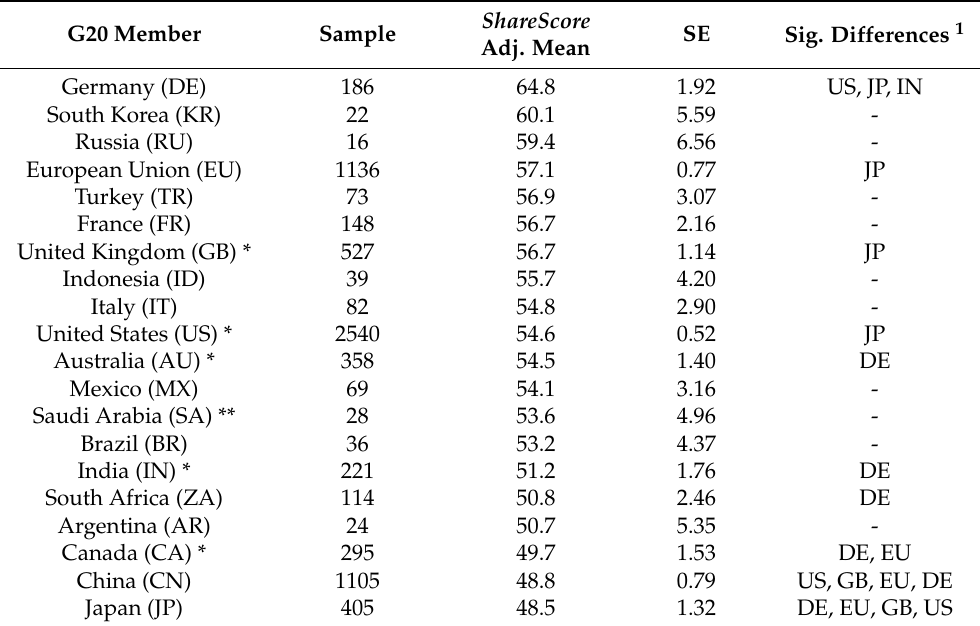
Table 3. The analysis of covariance of ShareScore by country/group of countries, adjusted for company size, in descending